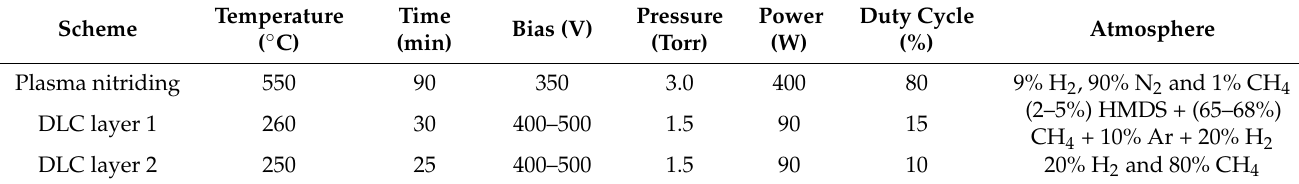
Table 2. Plasma nitriding and diamond-like carbon (DLC) deposition